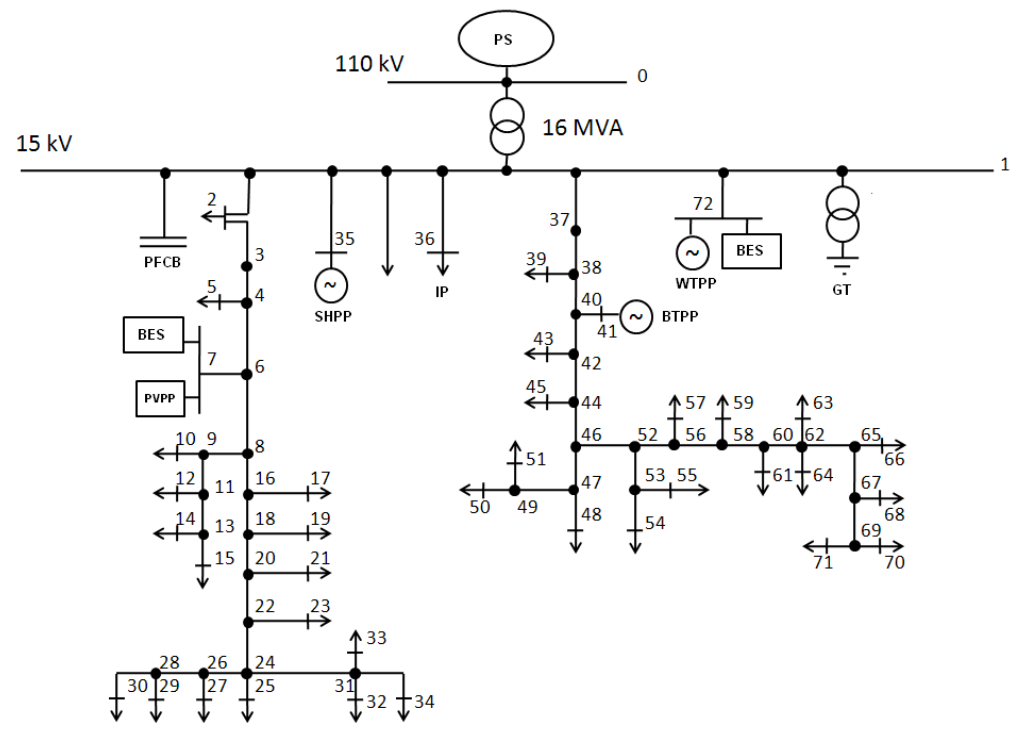
Figure A3. Rural MV distribution network with the distributed generation sources (PS—power system, PVPP—photovoltaic power plant, BES—battery energy storage, SHPP—small hydropower plant, BTPP—biogas-turbine power plant, WTPP—wind-turbine power plant, PFCB—PFC capacitor bank, GT—grounding transformer, IP—industrial Table A3. Distributed generation sources and energy consumers connected to the rural MV distri- bution network.